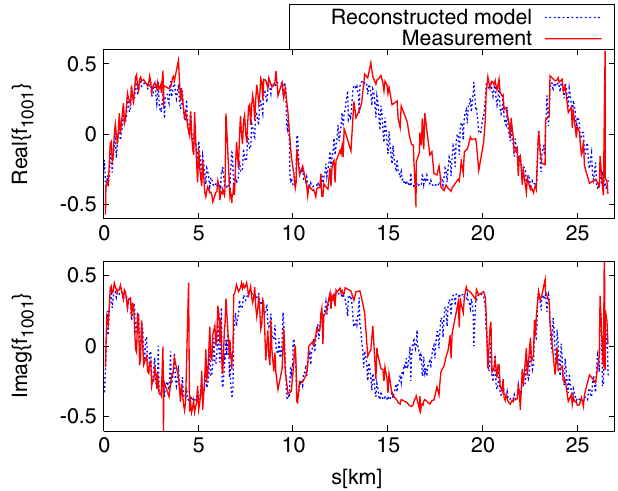
FIG. 10. (Color) Real and imaginary parts of the coupling reso- nance driving term f 1001 compared with a model reconstructed via the skew quadrupole response matrix.